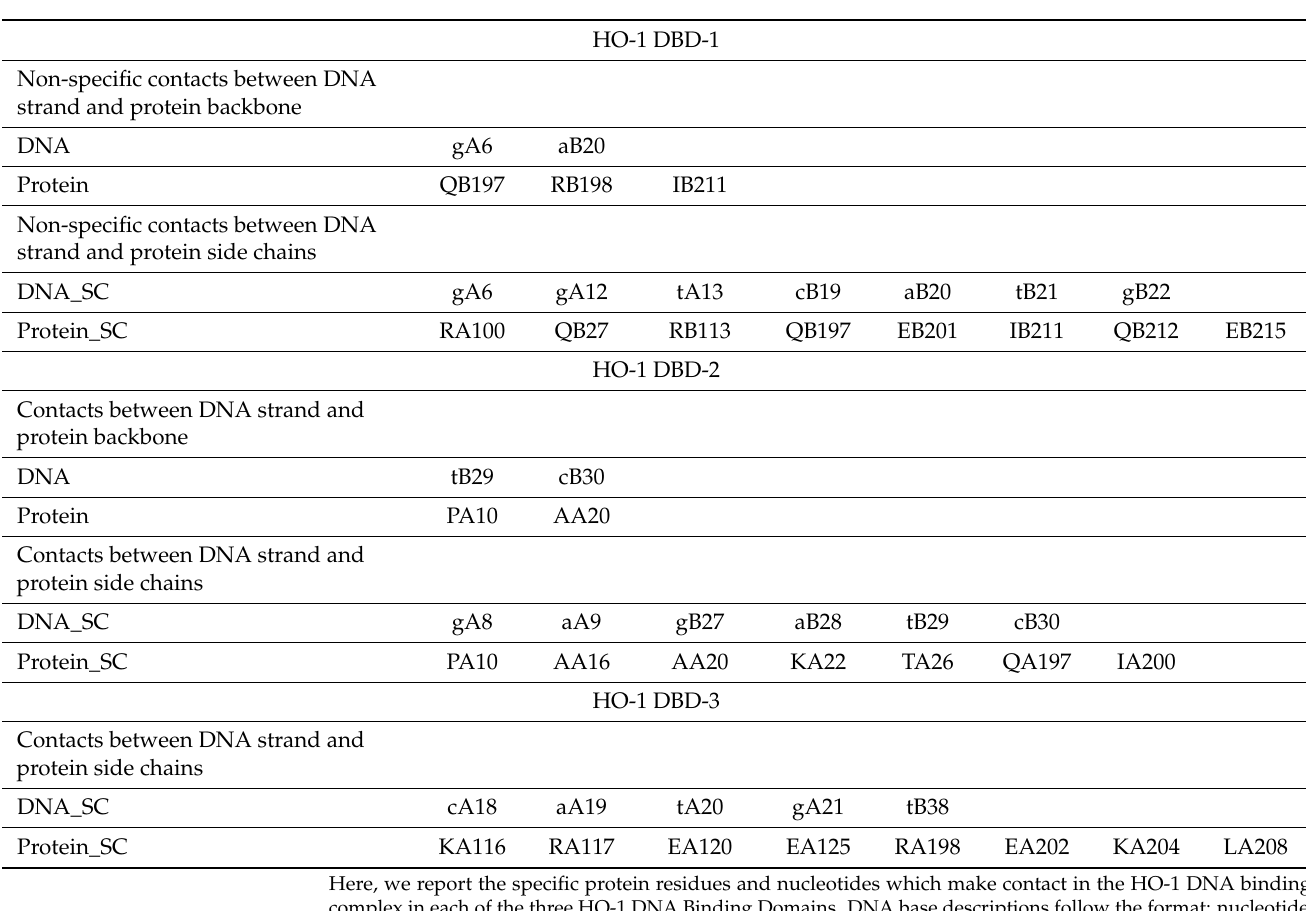
Table 3. Specific dsDNA-peptide contact positions within each HO-1 DNA binding